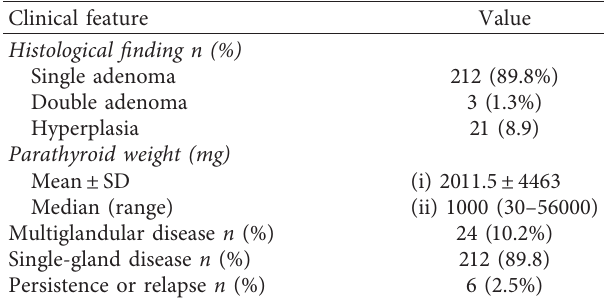
Table 4: Definitive diagnosis and success of surgery. Clinical feature